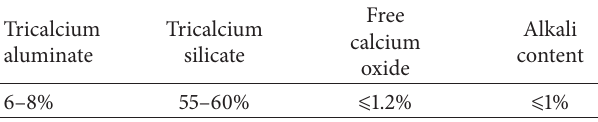
Table 1: Contents of main components of reference